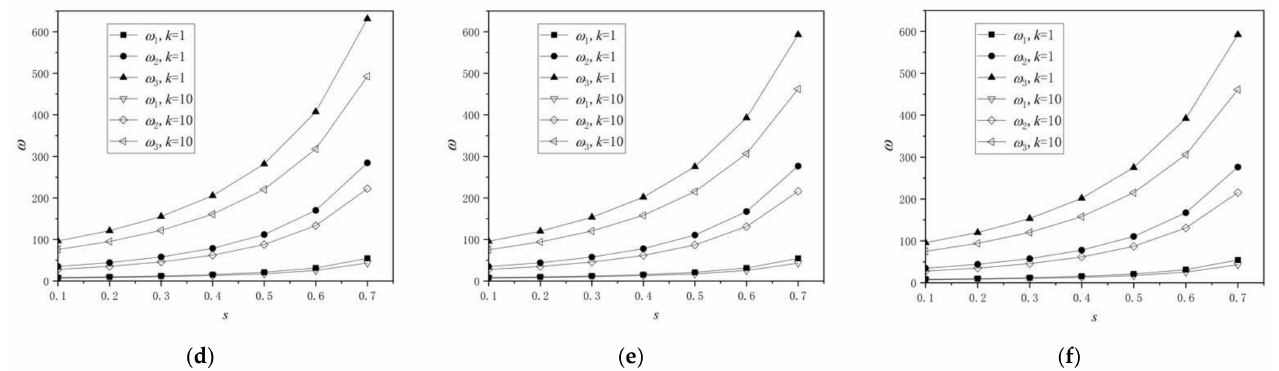
Figure 2. The relationship between dimensionless natural frequencies and the ratio of the inner and outer radius under two different boundary conditions. ( a ) C-C Kirchhoff plate; ( b ) C-C Mindlin plate; ( c ) C-C Reddy plate; ( d ) C-F Kirchhoff plate; ( e ) C-F Mindlin plate; ( f ) C-F Reddy